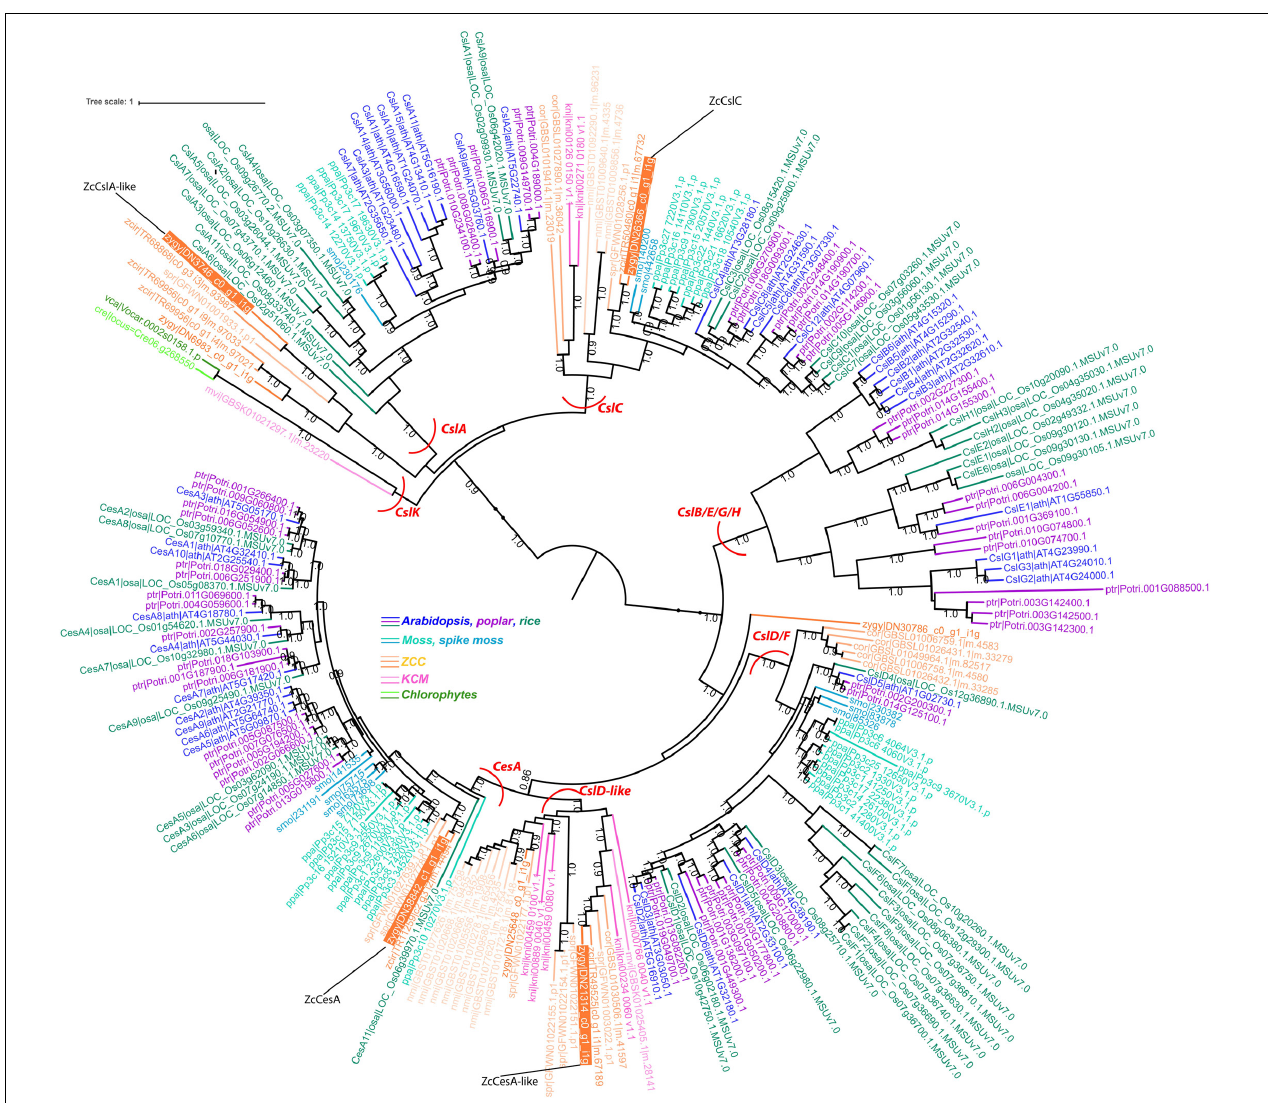
FIGURE 3 | The phylogeny of GT2 proteins from selected species of land plants and algae. In total 248 GT2 protein sequences of 14 plant and algal species were used to build this phylogeny (see section “Materials and Methods”). For Arabidopsis and rice proteins, the gene names (adopted from Wang et al., 2010; Yin et al., 2014) were included in the tree leaves. The UTEX 1559 proteins that were selected for qRT-PCR analysis were highlighted with orange background and the proposed gene names ( Table 5 ) were indicated with black